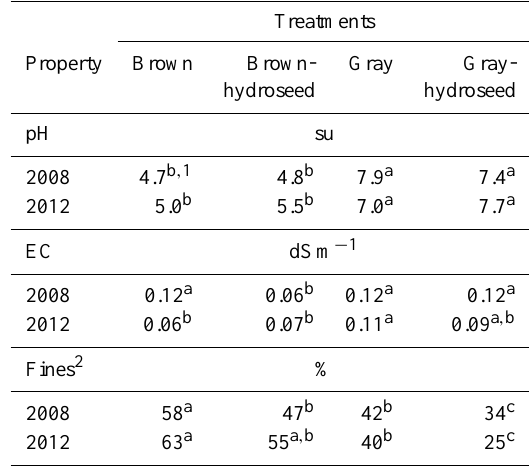
Table 6. Carbon and nitrogen fractions in mine soil samples af- ter six growing seasons at the Birch River Operation in Webster County, WV.